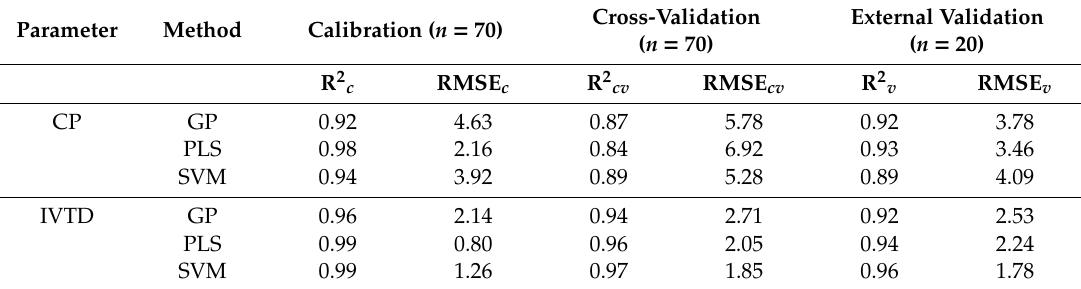
Table 4. Calibration, cross-validation, and external validation statistics obtained for crude protein (CP) and in vitro true digestibility (IVTD) in soybean using three calibration